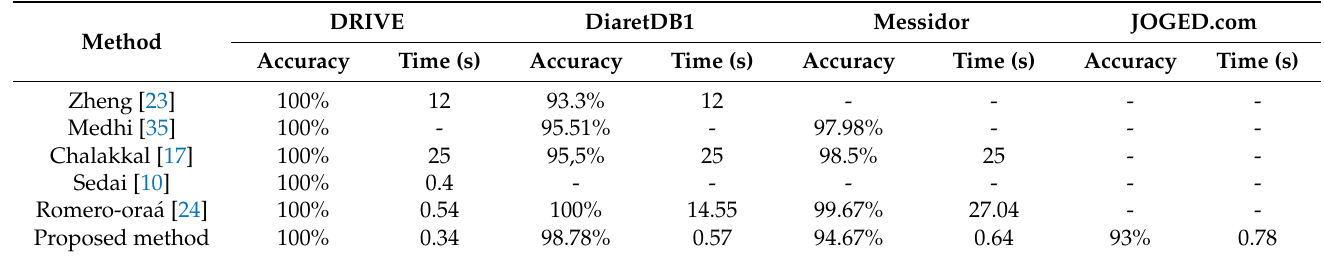
Table 1. Comparison of macular center detection results with other